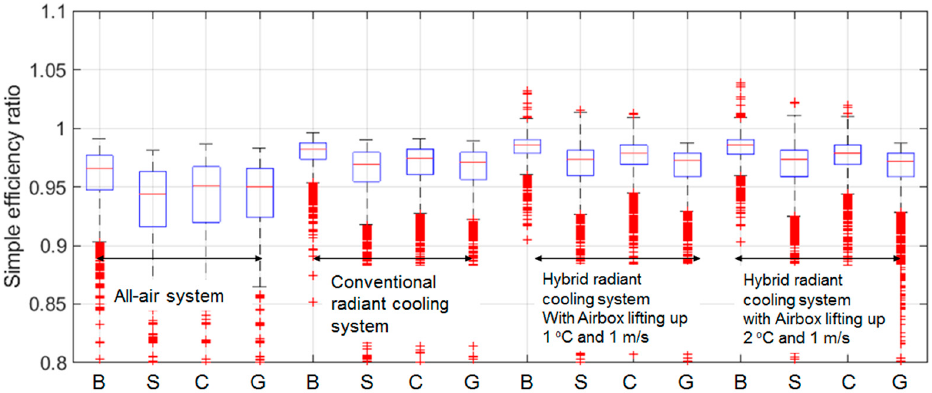
Figure 8. Simple exergy efficiencies of the three cooling systems in four cities: B—Beijing, S—Shanghai, C—Chengdu, and G—Guangzhou.